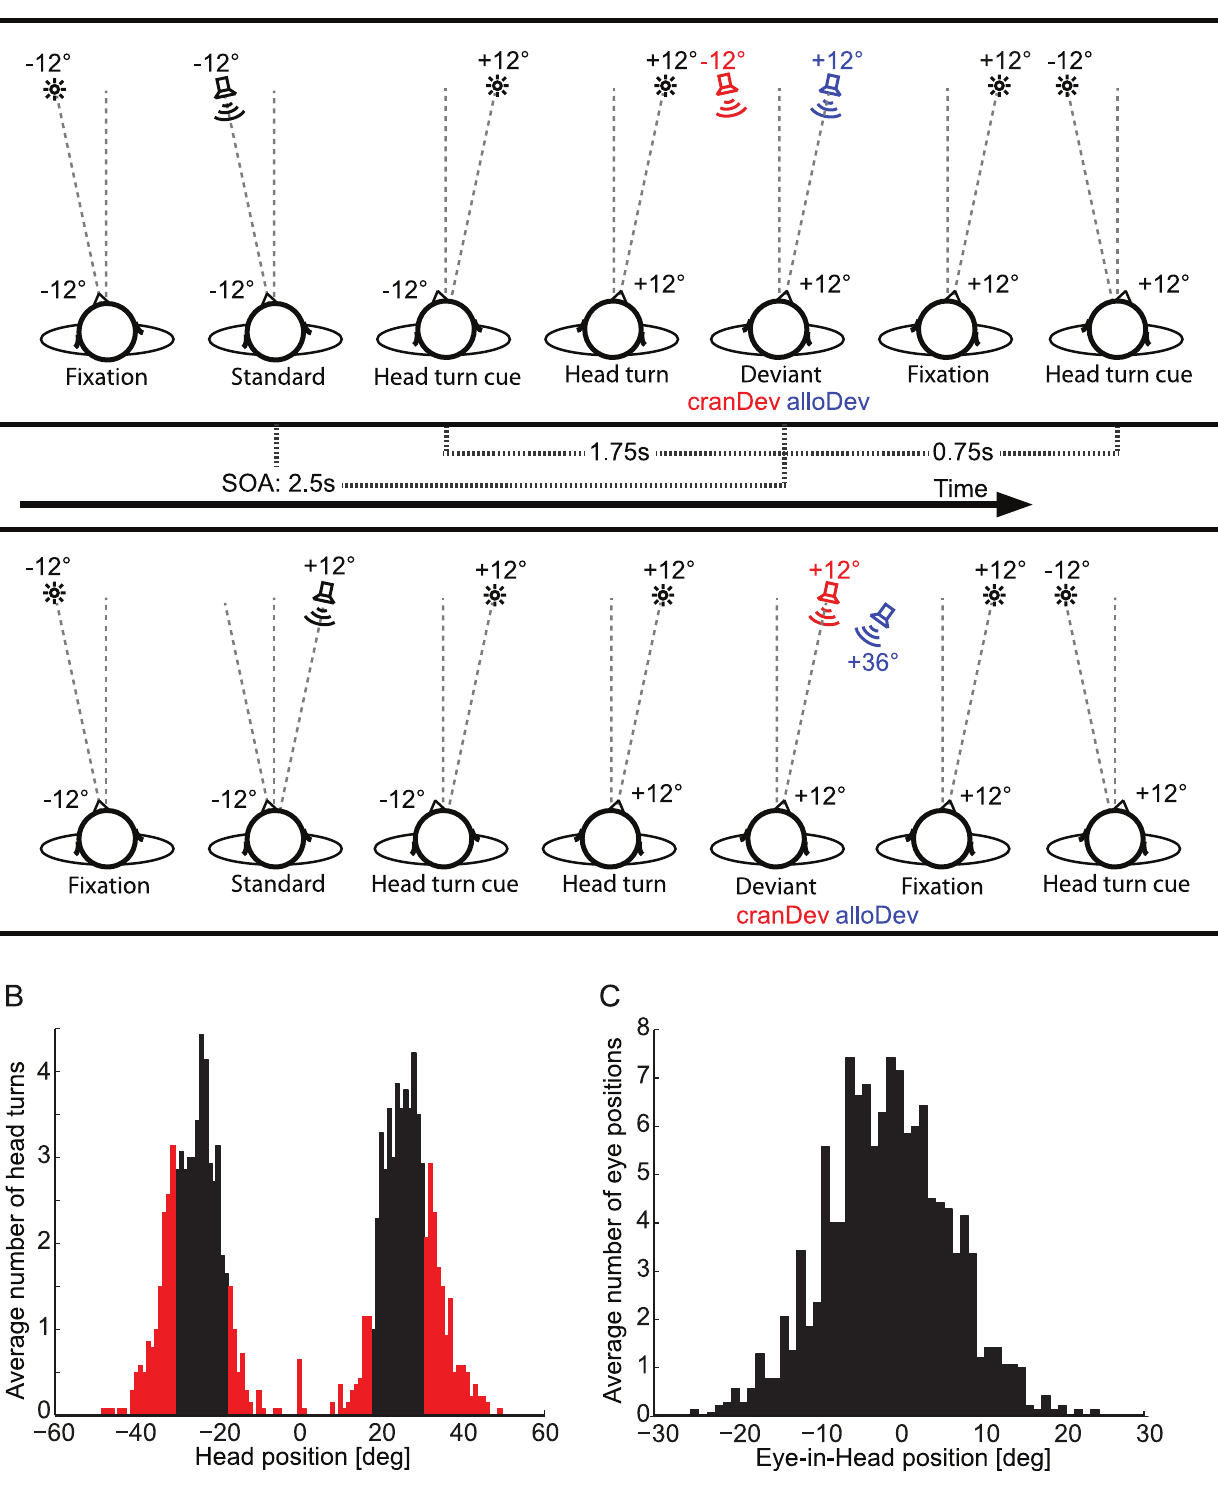
Figure 1. Experimental procedures and behavioral performance. (A) Experimental conditions. The upper row illustrates conditions with standard series for which the stimuli were presented in the median plane of the subject’s head, and the lower row illustrates conditions with standard series for which stimuli were presented laterally to the median plane of the subject’s head. The standard series (Std) was followed by a deviant (Dev) which was either craniocentric (cranDev, red) or allocentric (alloDev, blue). The angles next to the schematic heads ( 2 12 u and + 12 u ) indicate the orientation of the head in relation to trunk median sagittal plane. The angles ( 2 12 u , + 12 u , + 36 u ) adjacent to the loudspeakers and fixation targets (stars) indicate the stimulus positions. Only left to right head movements are shown. In half of the blocks, subjects had to perform right to left head